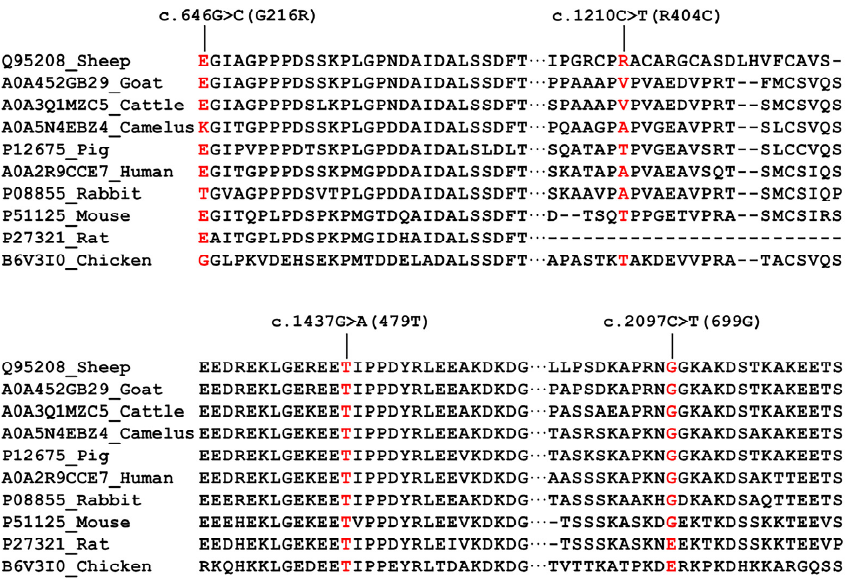
Figure 4. Alignment of the wild-type sequence in various species in the CAST amino acid. CAST multispecies alignment in the region of missense mutations. Using the Uniprot database, CAST amino acid sequences were obtained for each species.